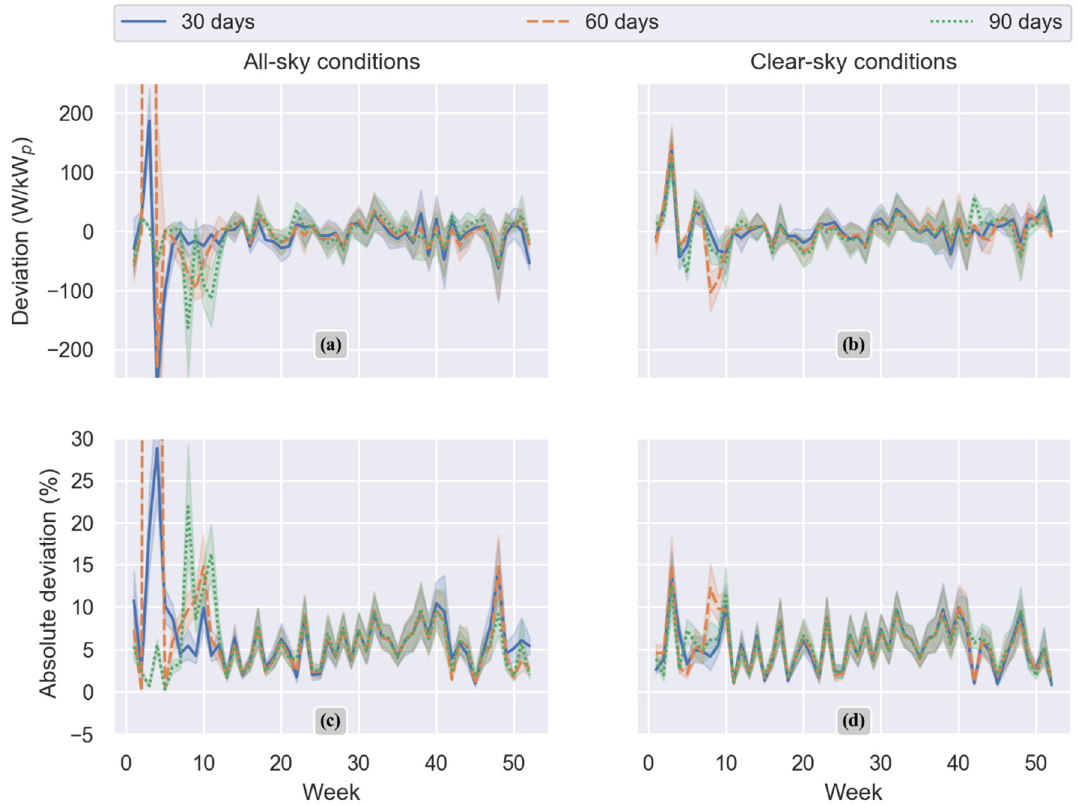
Figure 8. Digital twin now-casting results based on GA optimization. 52 chosen days of year 2017. Six different training data sets for each day were considered: all-sky and clear-sky conditions with 30, 60, and 90 days of training data sets. The lines represent the mean value and the shadows show a confidence interval of 95%, only daytime values are considered.